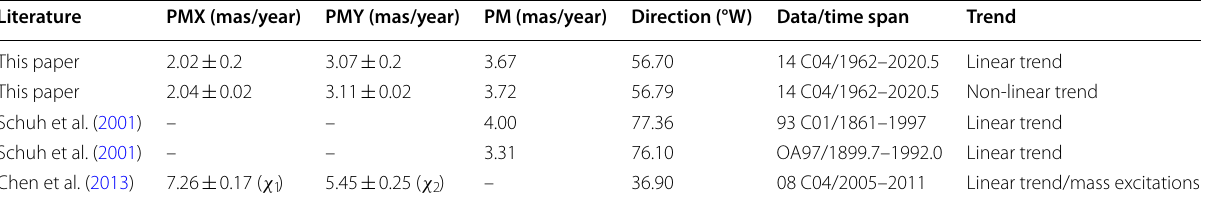
Table 1 Long-term trends of polar